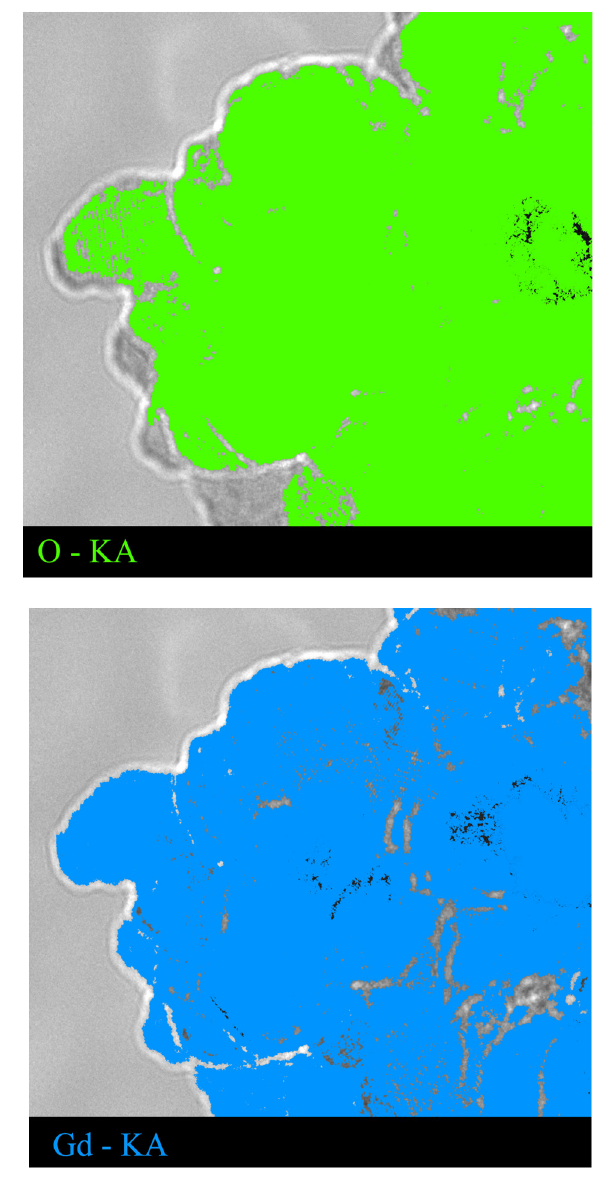
( e ) Figure 2. TEM images of the studied nanostructures: ( a ) S0; ( b ) S1; ( c ) S2; ( d ) S3; ( e ) S4.